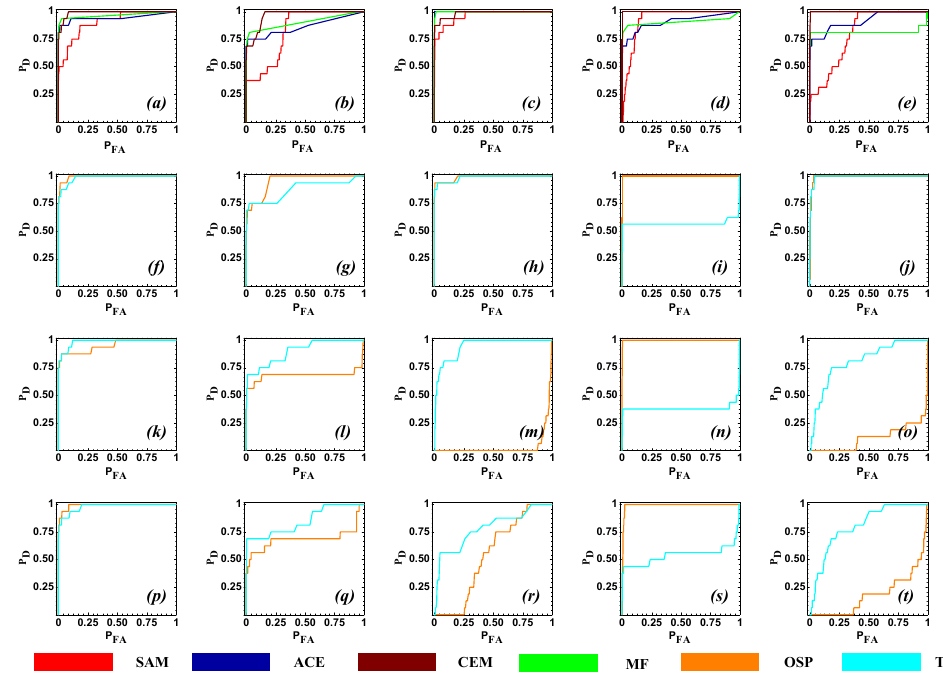
Figure 5. Target detection performance comparison in airborne imagery for the in-situ target reference spectra. Receiver operation curves (ROC) for the detection from spectral angle mapper (SAM), adaptive cosine estimator (ACE), constrained energy minimization (CEM), and matched filter (MF) for the ( a ) N1G, ( b ) N2R, ( c ) C1W, ( d ) N3Y, and ( e ) N4B targets. ROC curves for the detection from orthogonal subspace projection (OSP) and transformed constrained interference minimization filter (TCIMF) for the N1G, N2R, C1W, N3Y, and N4B targets for ( f – j ) 5, ( k – o ) 10, and ( p – t ) 15 background materials.